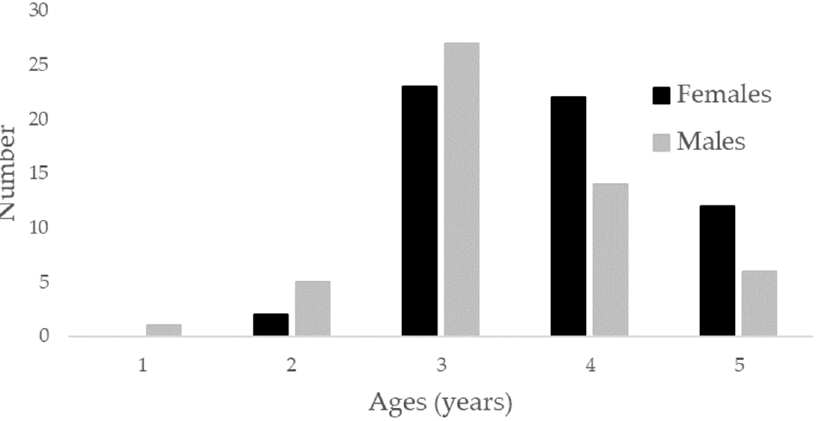
Figure 3. Age distributions of the European barracuda, Sphyraena sphyraena , females and males in the eastern Adriatic.